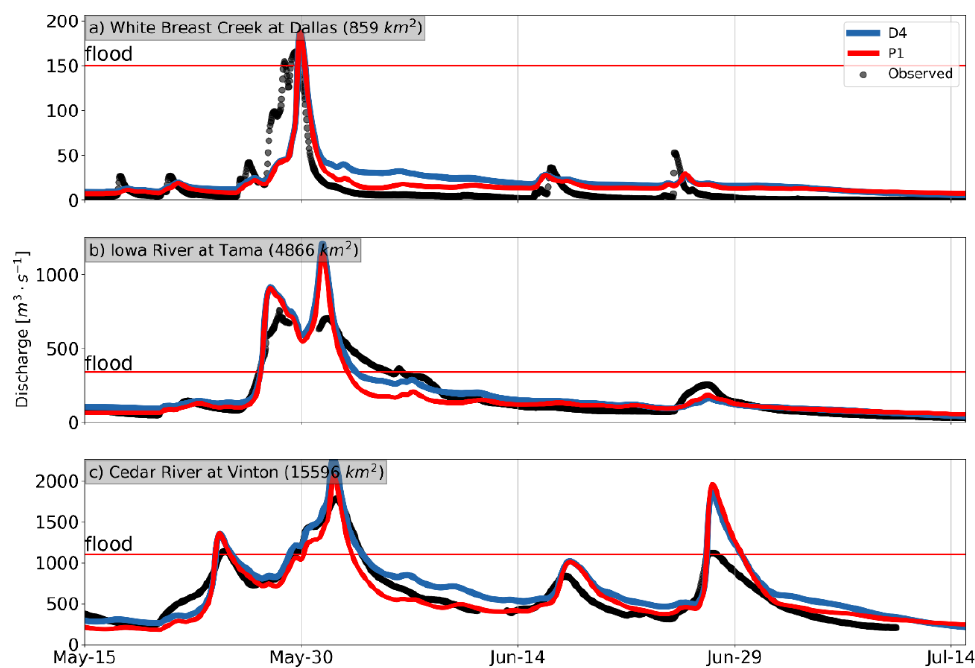
Figure 5. ( a – c ) Diagnostic (blue) and prognostic (red) simulations done for the year 2013. Results are compared with the USGS observations (black).